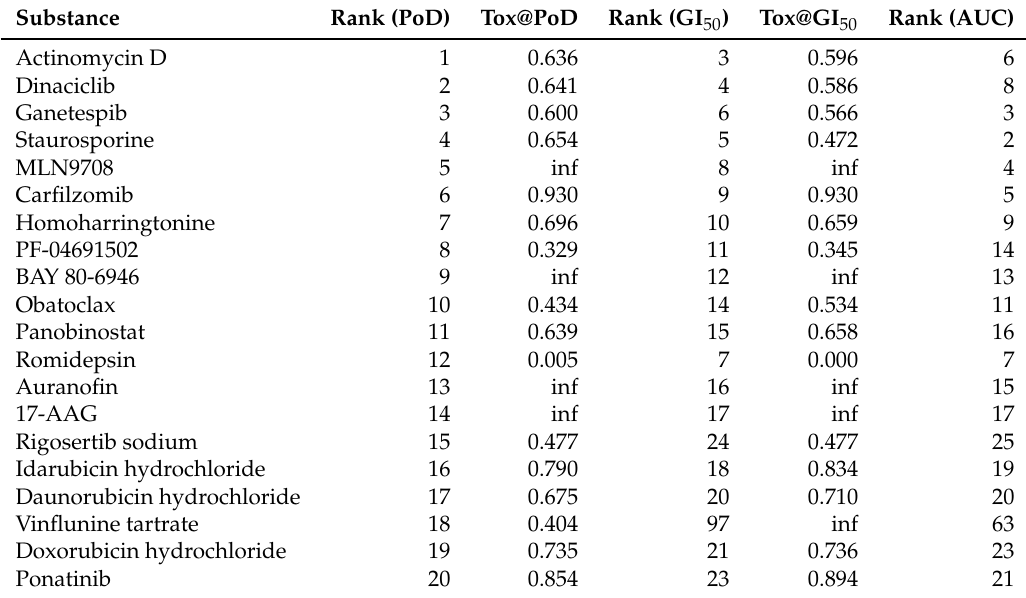
Table 2. Top 20 drugs and their toxicities, ranked by